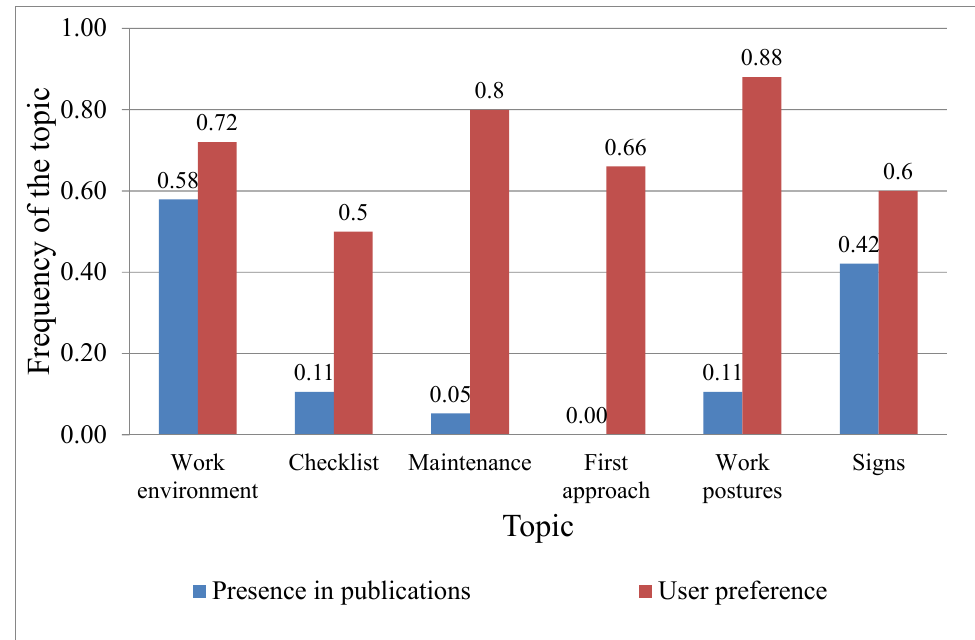
Figure 3. Frequencies of the topics dealt with in the sample of the 19 analysed publications (blue) and the normalized average scores expressed by the 19 operators (red) in the Training category.